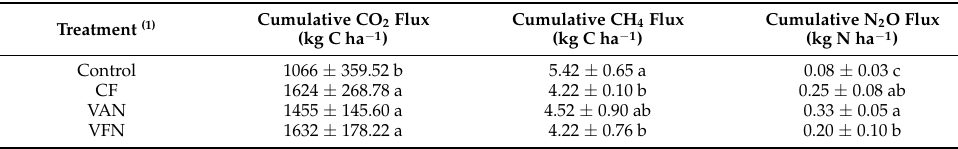
Figure 1. Meteorological information observed during the growing season. (a) indicate the emission sampling periods during the crop cycle. Table 2. Cumulative emission of CO 2 , CH 4 and N 2 O for different